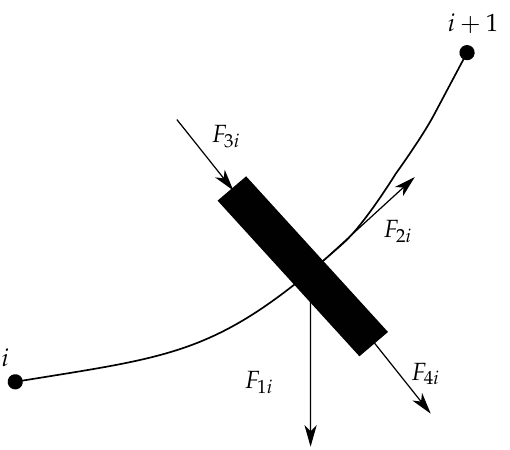
Figure 10. External forces acting on an element of line. The added mass force per unit of unstretched line length was calculated in OPASS based on a normal added mass coefficient C mn for the Morison